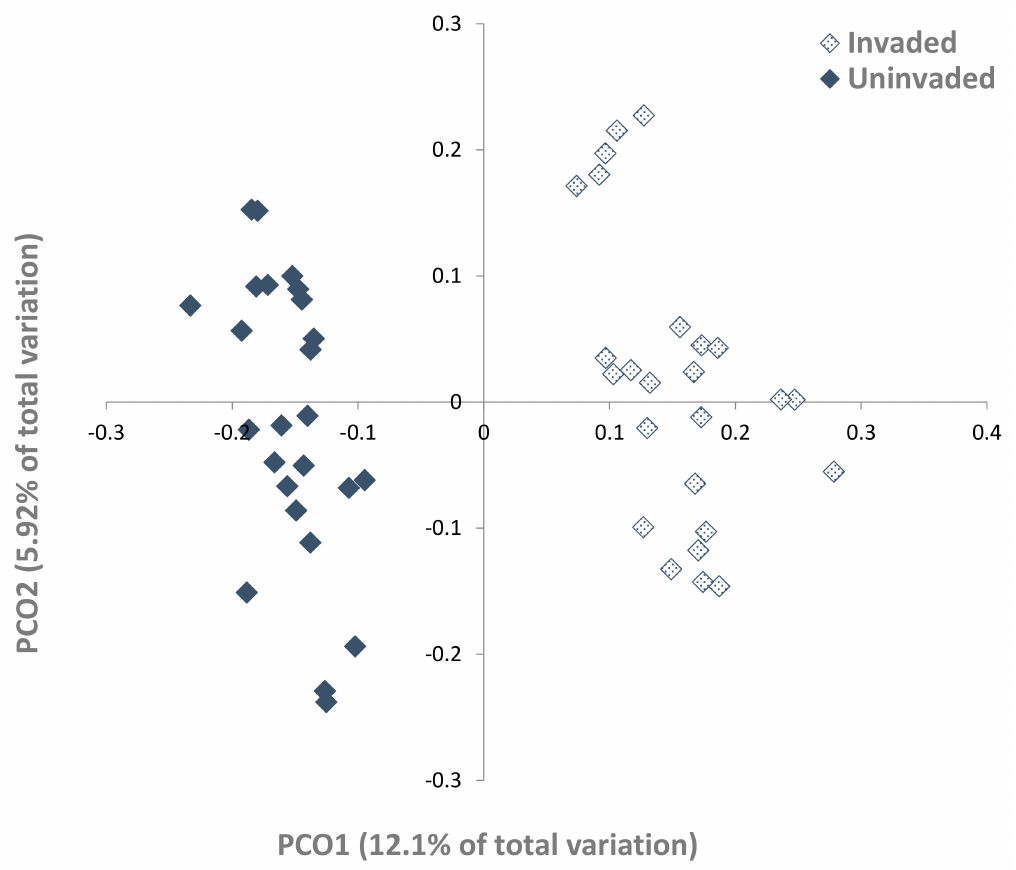
Figure 2. Principal coordinate ordination (PCO) of soil fungal communities in invaded and uninvaded grasslands(25sampleseachsite), showingaclearseparationbetweenthetwocommunities(permutation multivariate analysis of variance (PERMANOVA) Pseudo- F = 7.9509, p = 0.001; analysis of similarity (ANOSIM) r = 0.509, p =